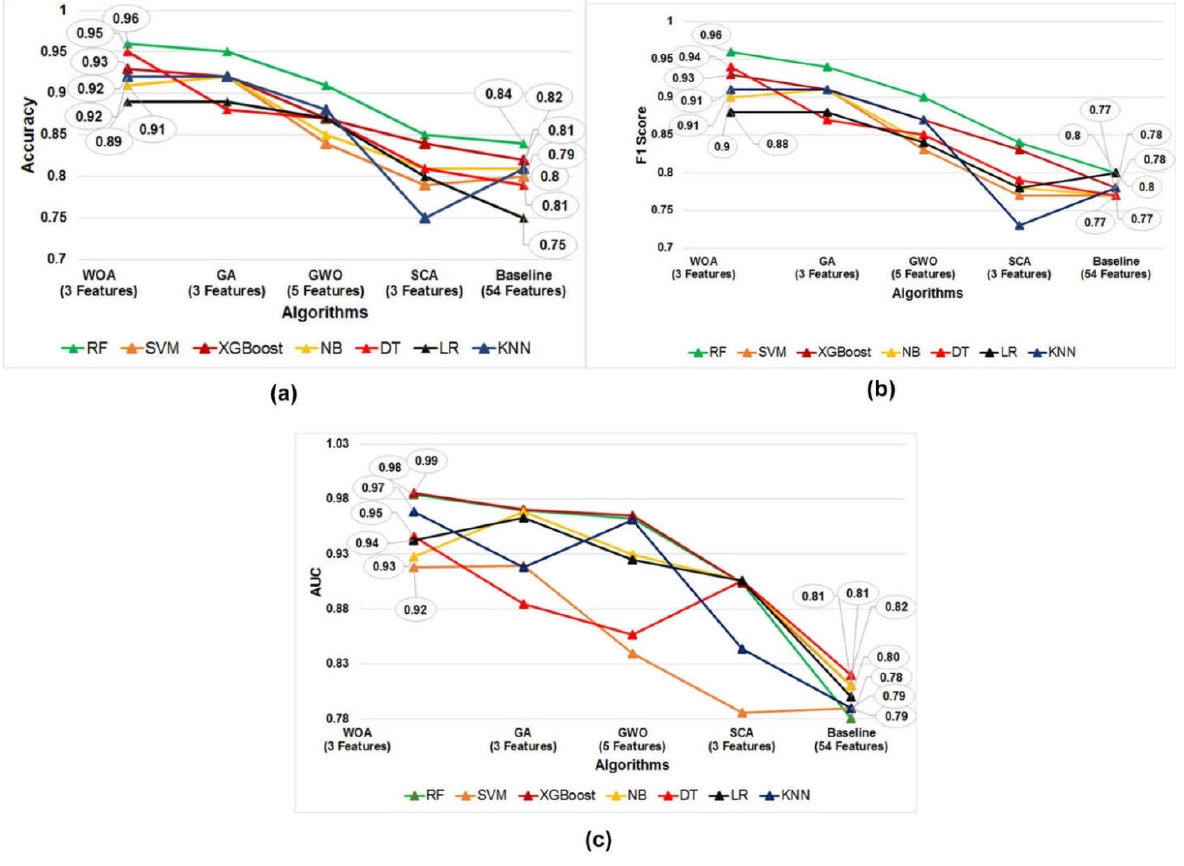
Figure 5. Comparison of the performance matrices. ( a ) Accuracy, ( b ) F1 score, and ( c ) AUC value of the three predictive models built using the four optimal feature subset obtained by WOA, GA, GWO, and SCA meta-heuristic algorithms.